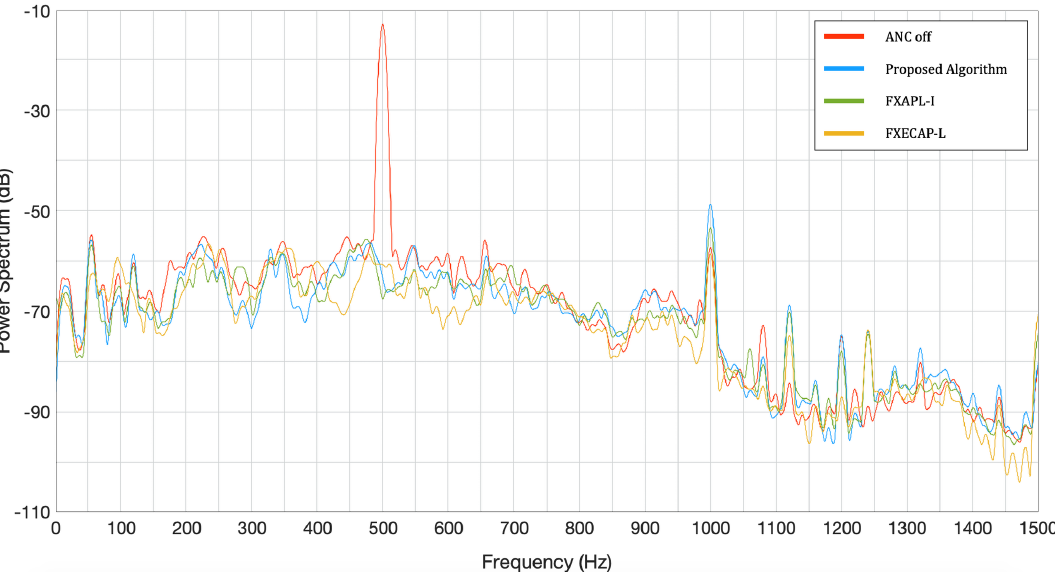
Figure 7. Power spectrum of the error signal at microphone (#1) considering a single-tone as a reference signal.